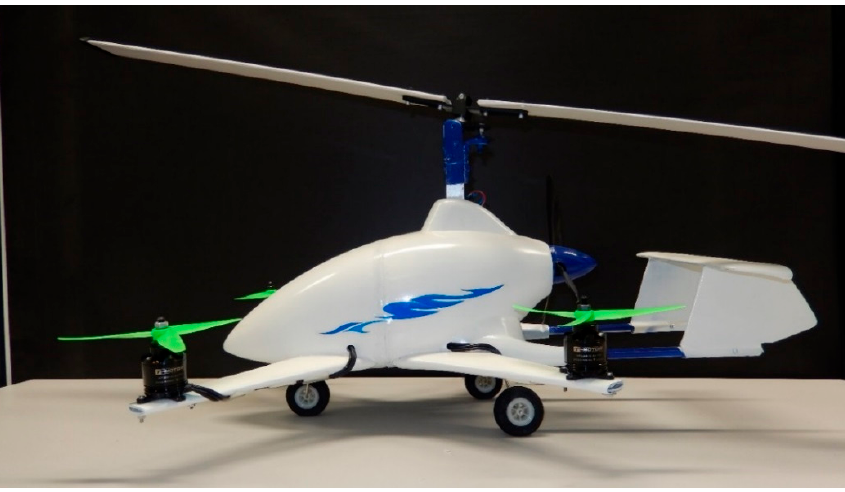
Figure 1. View of a complete aircraft with additional propulsion units—side view.